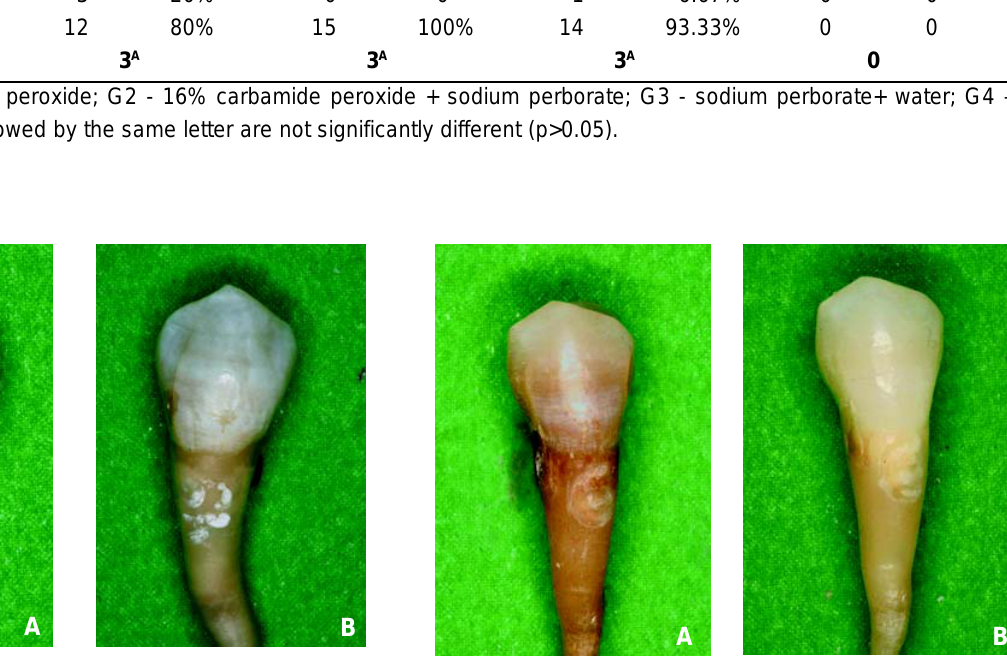
FIGURE 1- Specimen representative of control group (G4) after discoloration (A) and after 21 days of bleaching (B)